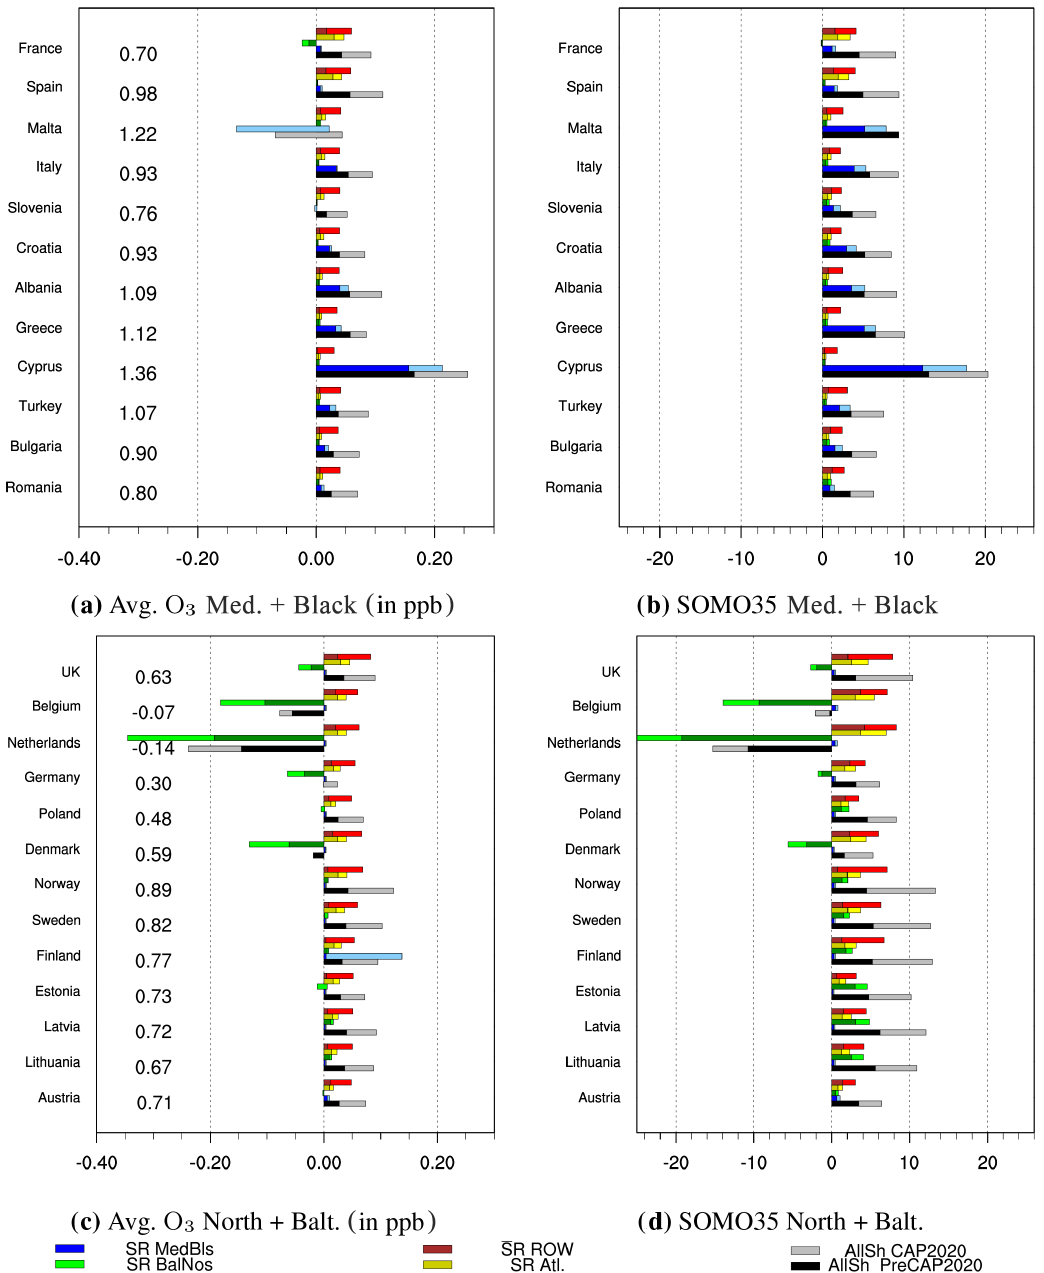
Figure 6. Contributions from shipping (in ppb) to annually averaged ozone from 15% reductions in ship emissions (a, c) . Numbers to the right of the country names are the effects of the 15% reductions in all anthropogenic emissions calculated as Base_2017–SR_AllSh. (b, d) Percentage contributions to SOMO35 relative to contributions from all global anthropogenic emissions. Contributions are shown for all ships and separated by sea area. The lengths of the bars are split so that the darker parts of the bars represent calculations assuming ShipNO x (see Sect. 2) and the full length without ShipNO x . Note that for Malta the smaller perturbation in NO x from Mediterranean shipping with ShipNO x results in a small parts per billion increase in calculated ozone, whereas the larger perturbation without ShipNO x results in a